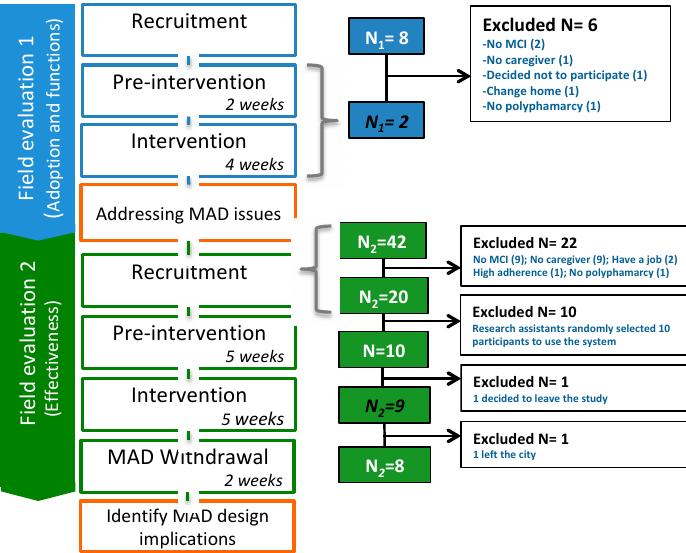
Figure 4. Flow diagram of MAD assessment: the right side represents the participants’ (N) progress through the stages of each field evaluation depicted in the left